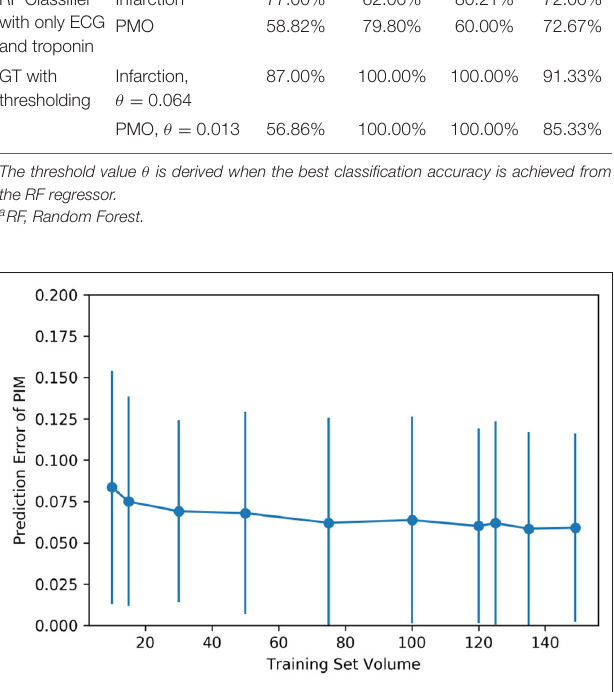
FIGURE 4 | Impact of the training set volume on the mean and the SD of quantification error. The dataset of 150 cases was randomly split into multiple folds to have different amounts of training data. The training set volume ranged from 10 to 149 for each